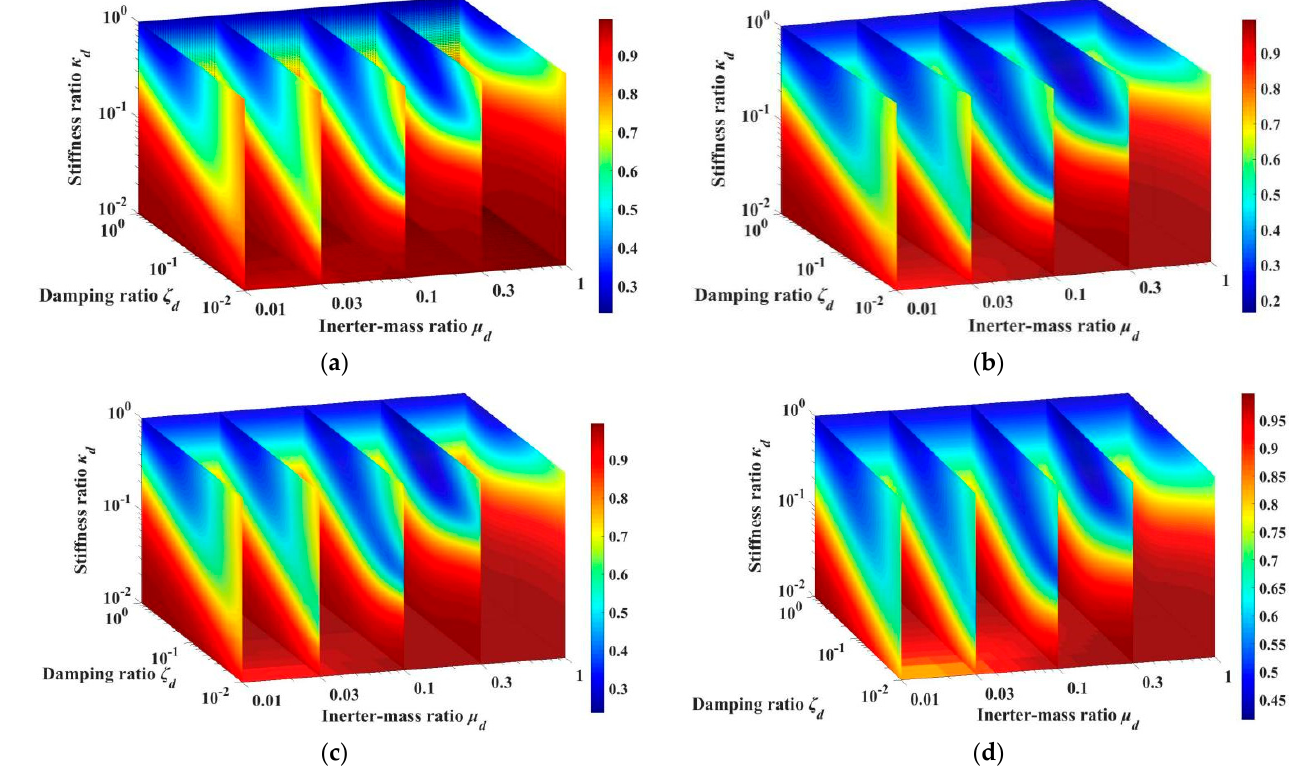
Figure 12. Slice plot of γ U : ( a ) β = 0; ( b ) β = 0.2; ( c ) β = 1; and ( d ) β = 5.